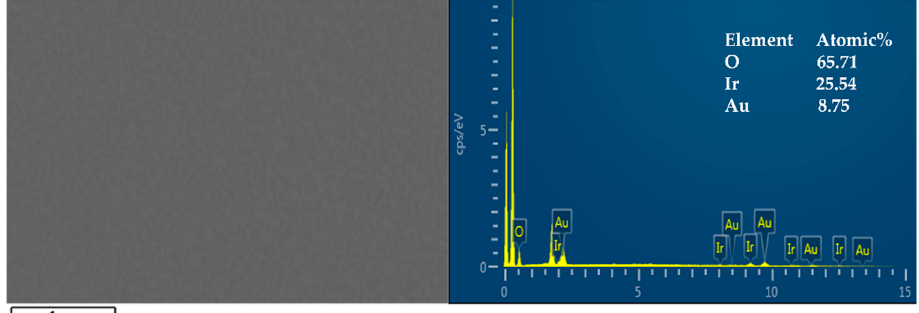
Figure 3. The surface morphology and EDS of iridium oxide film; insets are the atomic percentage of different elements.